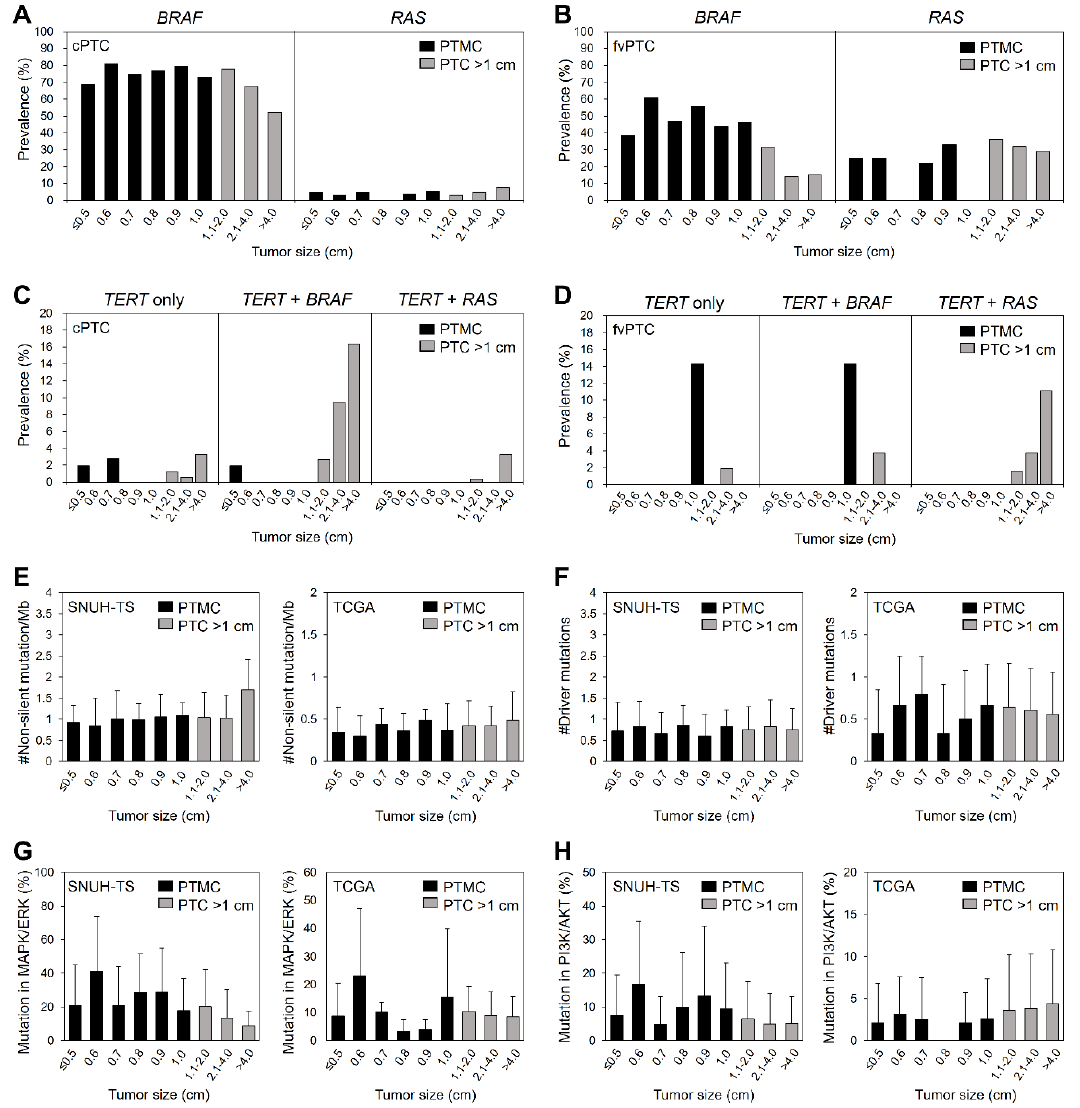
Figure 1. Genomic characteristics of papillary thyroid carcinoma according to tumor size. Prevalence of BRAF V600E and RAS mutations according to tumor size in ( A ) classical ( n = 2954 and 851 for BRAF V600E and RAS , respectively) and ( B ) follicular variant ( n = 342 and 217 for BRAF V600E and RAS , respectively) PTCs. Prevalence of TERT promoter mutations ( TERT alone, TERT + BRAF , and TERT + RAS ) according to tumor size in ( C ) classical ( n = 707) and ( D ) follicular variant ( n = 184) PTCs. ( E ) Tumor mutational burden, ( F ) number of driver mutations, and ( G ) proportions of non-silent mutations involved in mitogen-activated protein kinase (MAPK)/extracellular signal-regulated kinase (ERK) pathway and ( H ) in phosphatidylinositol 3-kinase (PI3K)/protein kinase B (AKT) pathways compared to total non-silent mutations, according to tumor size of PTC in the SNUH targeted sequencing (SNUH-TS, n = 221) and TCGA ( n = 496) datasets. cPTC, classical papillary thyroid carcinoma; fvPTC, follicular-variant papillary thyroid carcinoma; PTMC, papillary thyroid microcarcinoma; PTC, papillary thyroid carcinoma.